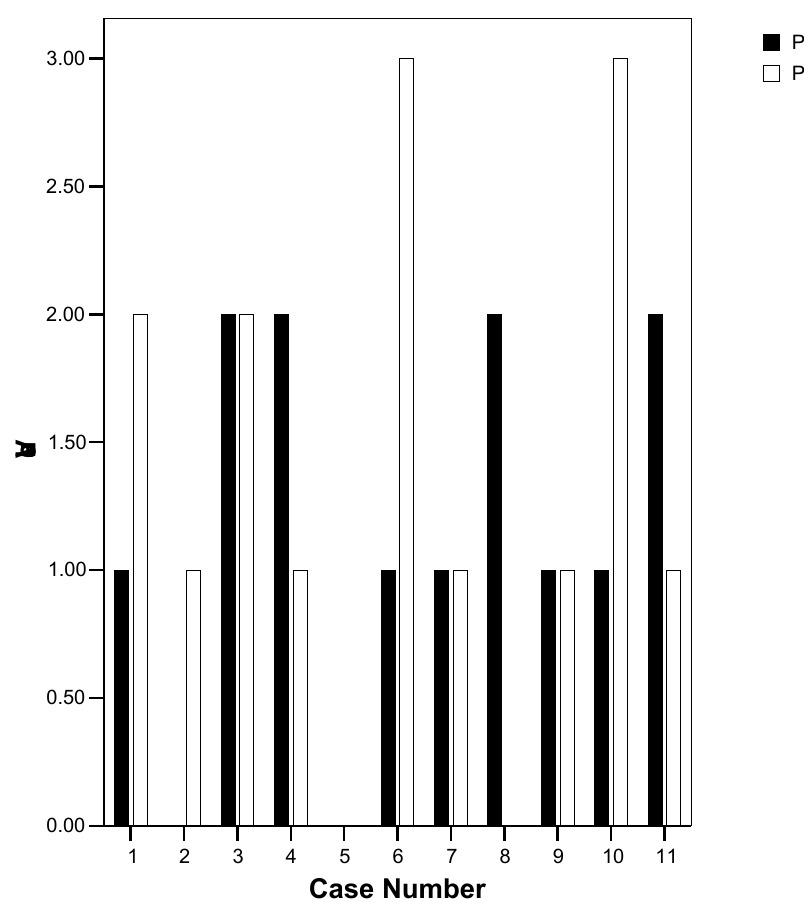
+Enhancement +Topic Familiarity